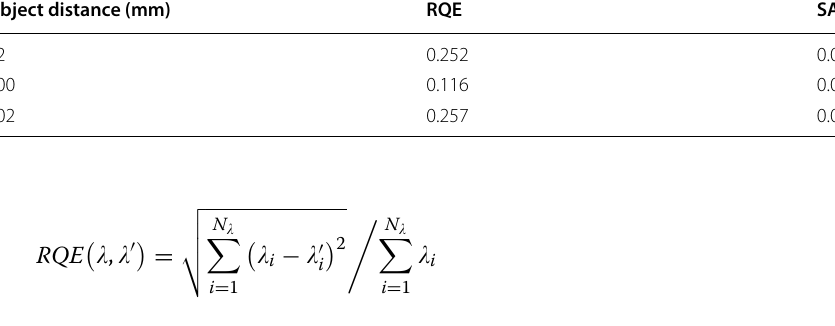
100 mm), e = 108 mm) =